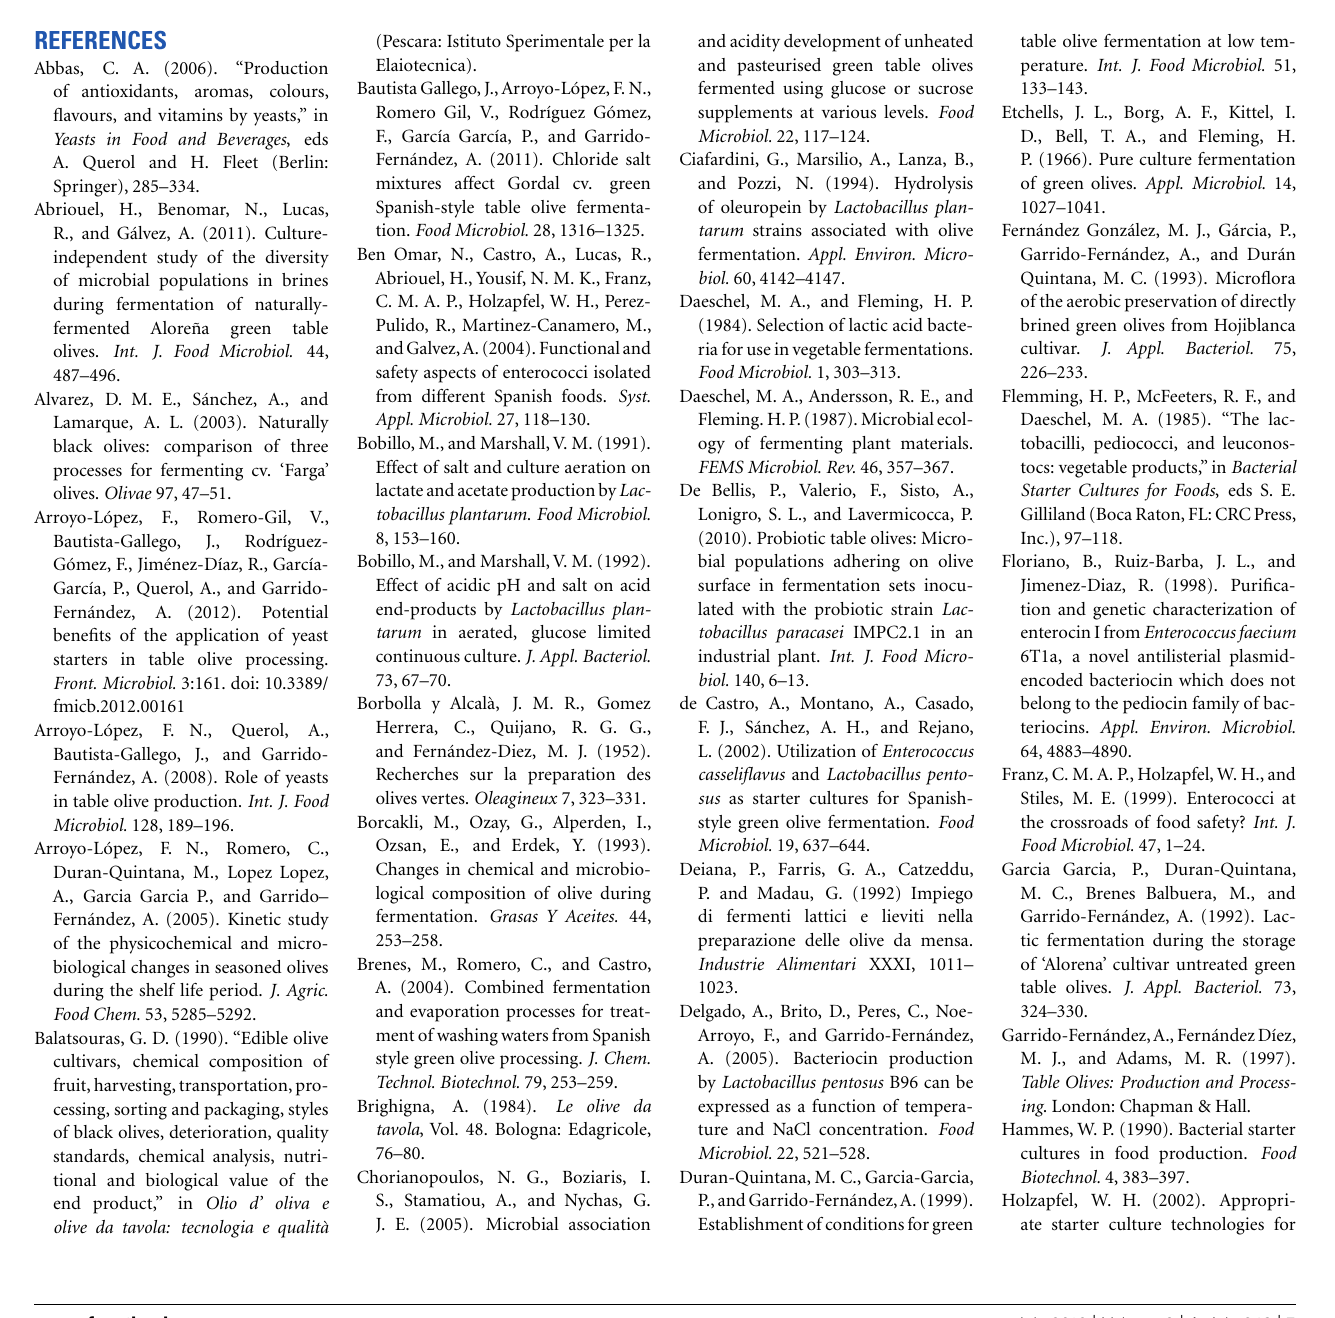
table olive fermentation at low tem- perature. Int. J. Food Microbiol. 51,